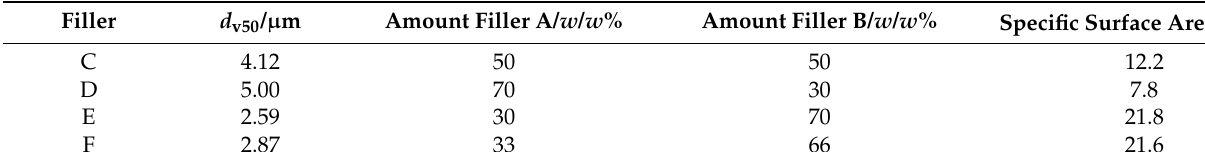
Table 3. Resulting filler particle data after filler mixing.